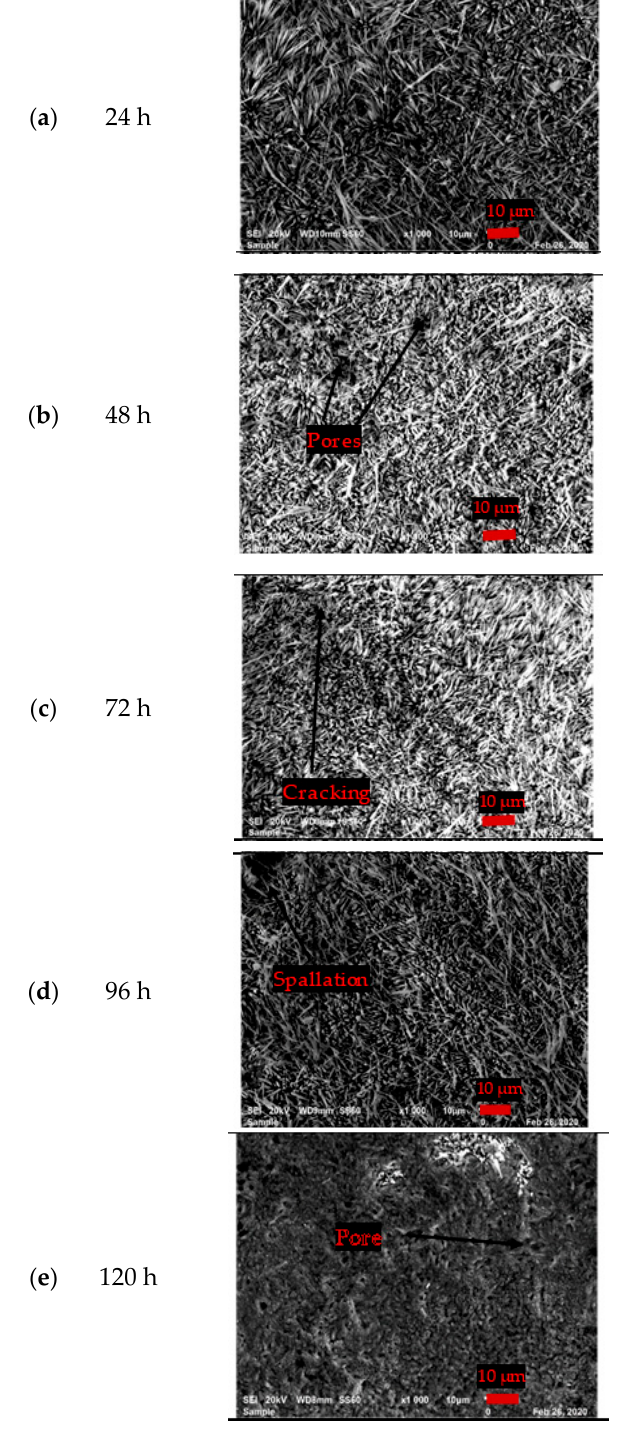
Figure 5. Surface morphology of EN8 for ( a ) 24, ( b ) 48, ( c ) 72, ( d ) 96 and ( e ) 120 h. Figure 5 shows that the oxide thickness grew to an average of 643.85 µm after 24 h. Internal crack- ing and pores can be observed in the oxide layer due to the oxide layer growth. This led